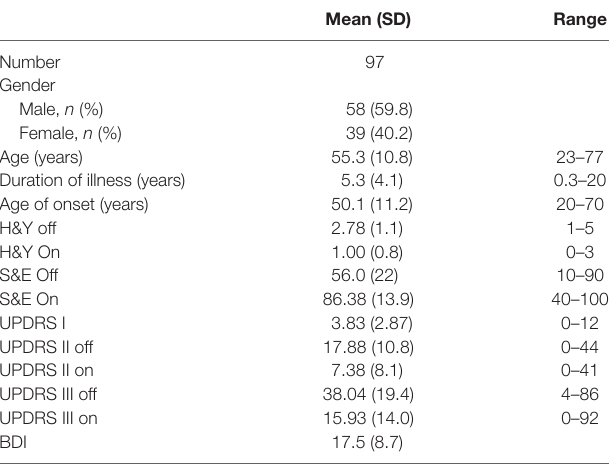
Table 1 | Demographic and clinical motor characteristics of PD patients.